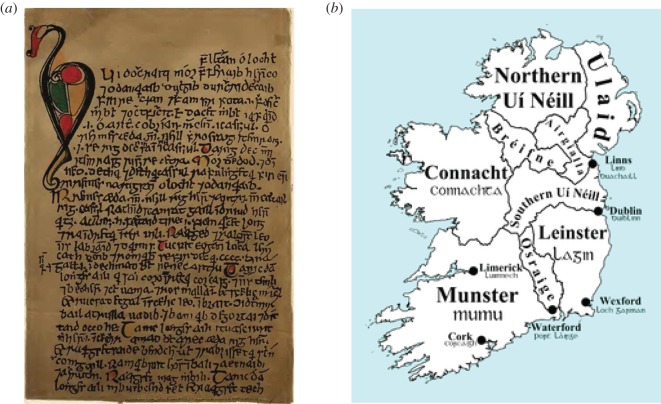
(a) Image of the nineteenth-century facsimile of the opening page of Cogadh Gaedhel re Gallaibh which was reproduced in Todd’s edition [4]. (b) The main kingdoms of Ireland ca AD 900 with principal (Viking) towns.